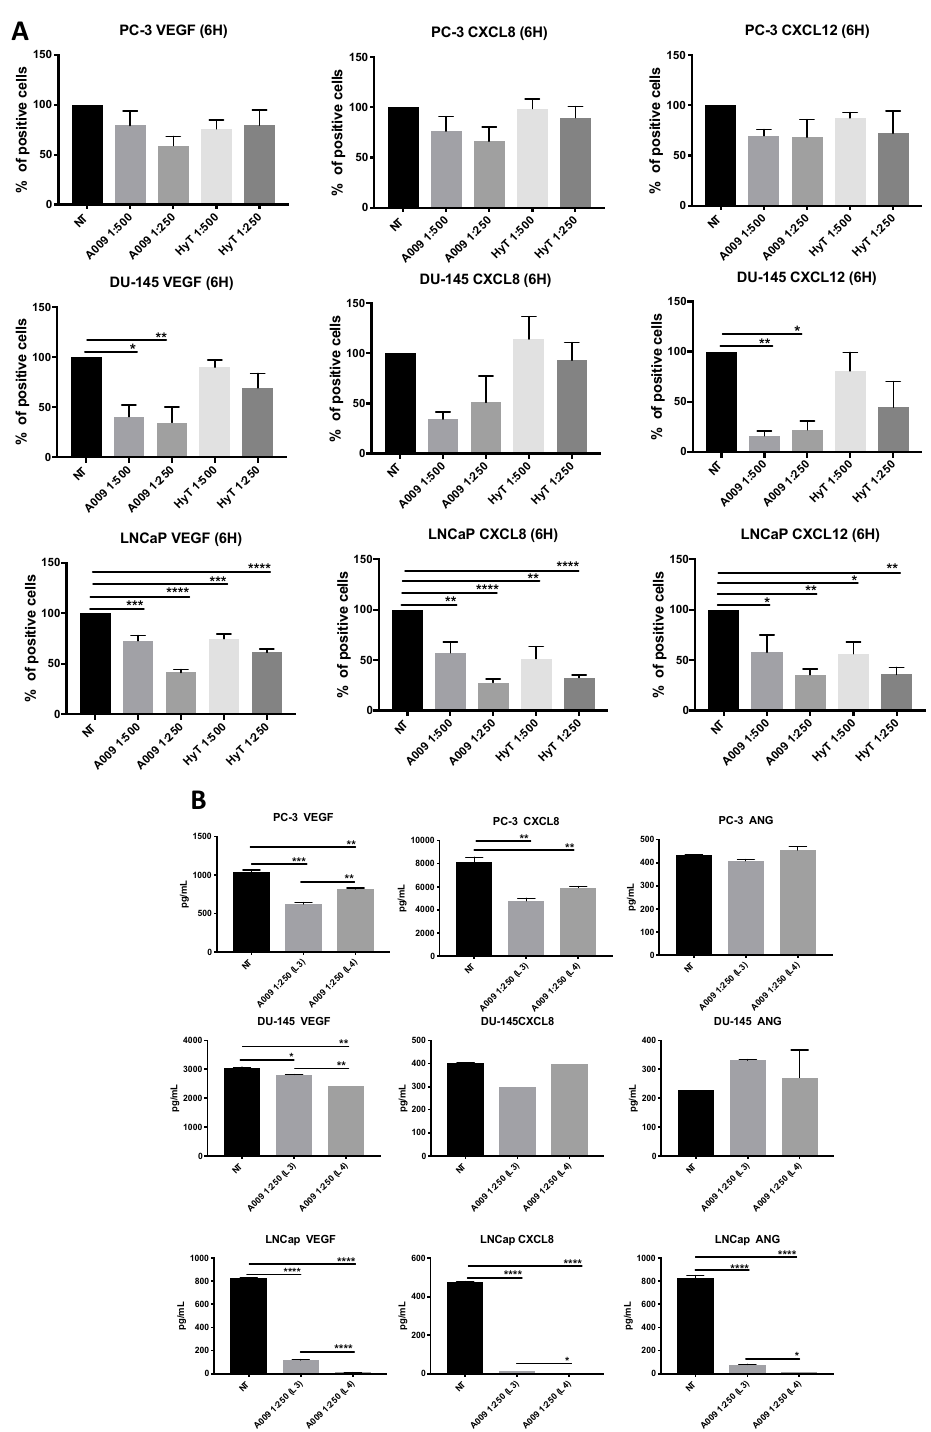
Figure 4. Cytokine profiling on PC-3, DU-145, and LNCaP human prostate cancer cells treated with A009. ( A ) PC-3, DU-145, and LNCaP were treated with A009 or HyT (dilution 1:500 and 1:250) for 6 h, and analyzed for cytokine production by flow cytometry. FACS analysis showed that A009 reduced VEGF, CXCL8, and CXCL12 release on PC-3, DU-145, and LNCaP PCa cell lines. ( B ) Secretome profiling on DU-145 and LNCaP secreted products, following 24 h treatment with A009 (L3 or L4, dilution 1:250), by BIOPLEX, showed the ability of A009 to inhibit production of VEGF and CXCL8 release in the three PCa cell lines investigated. The was particular strong in LNCap cells. Results are showed as mean ± SEM, ANOVA, * p < 0.05, ** p < 0.01, *** p < 0.001, **** p < 0.0001.